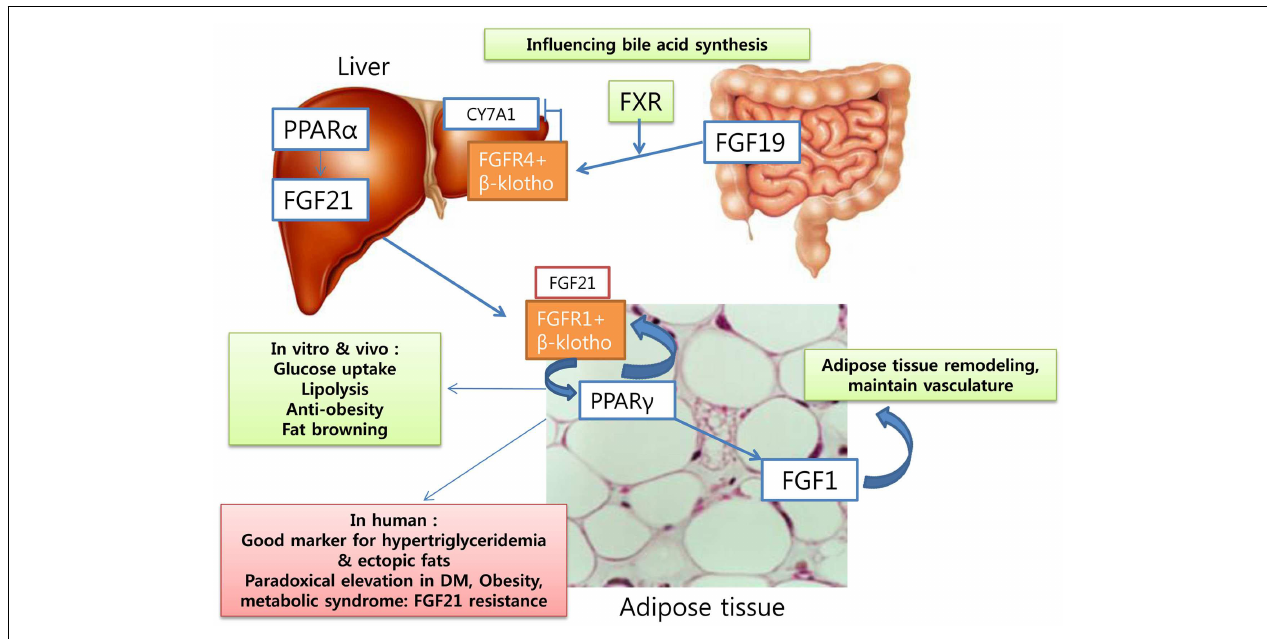
FIGURE 2 | Fibroblast growth factors: as metabolic regulators in human .